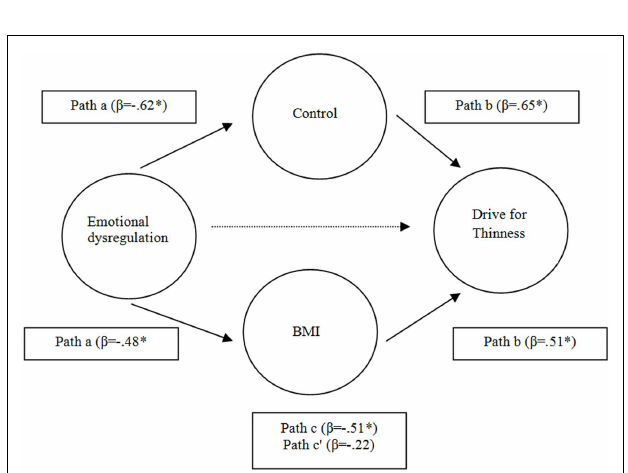
FIGURE 1 |The mediating role of control in relation between emotional dysregulation and drive for thinness . ** p < 0.01; * p < 0.05.